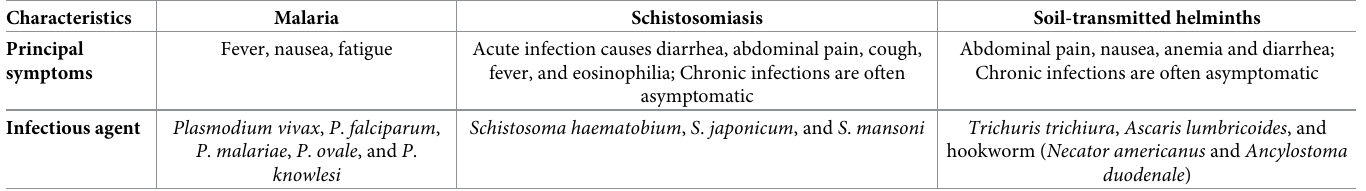
Table 1. Summary of principal characteristics of malaria, schistosomiasis, and soil-transmitted helminths.